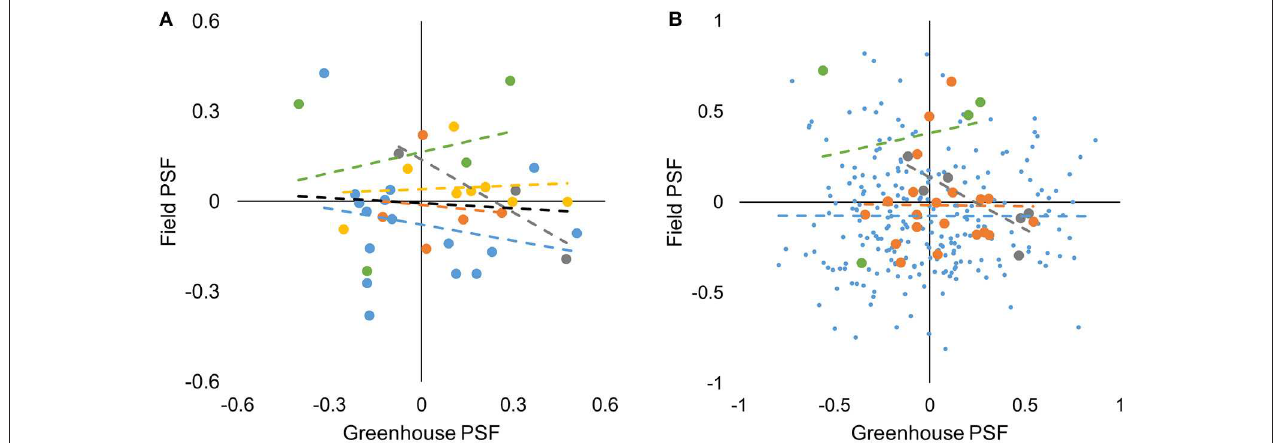
FIGURE 3 | Greenhouse- vs. field-measured species-level (A) and species*soil-level (B) PSF values from five study sites. Yellow, Berlin; blue, Cedar Creek; orange, Jena; gray, Potsdam; green, Winthrop; black is a best-fit line for all study sites. Though only significant for the Potsdam species*soil-level data, best-fit regression lines are shown for each site to demonstrate that slopes were close to